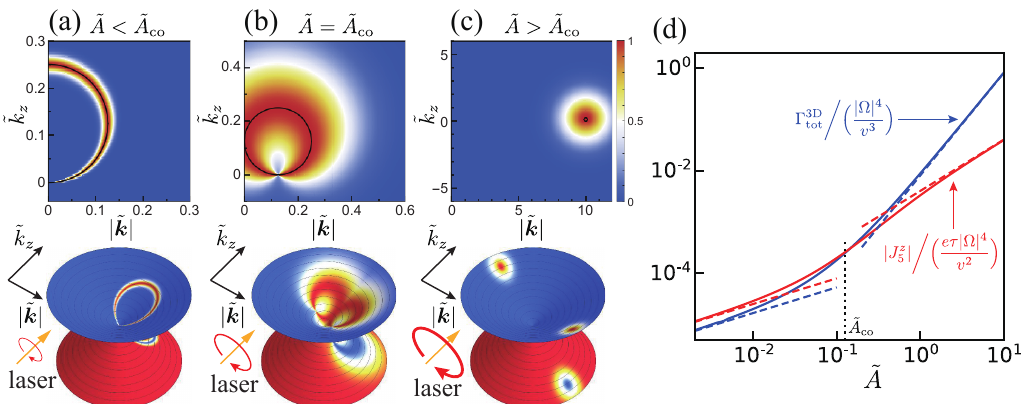
Figure 7: 3D massless Dirac fermion: (a)-(c) The production probability P ξ ( ˜ q ) for chirality ξ = + plotted for several field strength parameters (a) ˜ A = veE / Ω 2 = 0.001, (b) ˜ A = 1 / 8, and (c) ˜ A = 10. They are rotationally symmetric around the ˜ k axis and z → − ˜ k the probability for particles with chirality ξ = − is reflected as ˜ k . The solid z z black curve denotes wavenumber at which perfect tunneling occurs [ Eqs. (20) and ] . The lower panels show the fermion-antifermion pairs on (21) with m replace by k z (cid:112) | = 0. (d) The total production rate and chiral ˜ q | for fixed ˜ k the Weyl cone E = ± y current are plotted as blue and red solid curves while the dashed lines represent their asymptotic power-law behavior Eqs. (34) and